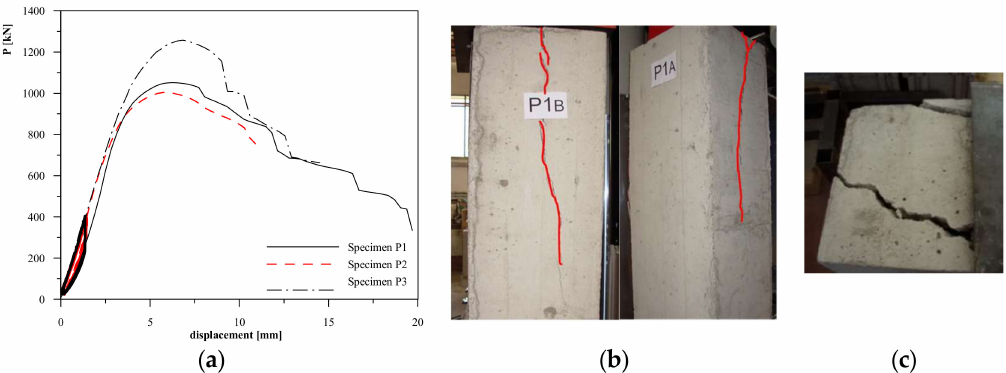
Figure 11. Push-out test in phase II (Badalamenti) [14]: ( a ). Load-displacement curves; ( b ) lateral view of specimen P1 at failure; ( c ) top view.